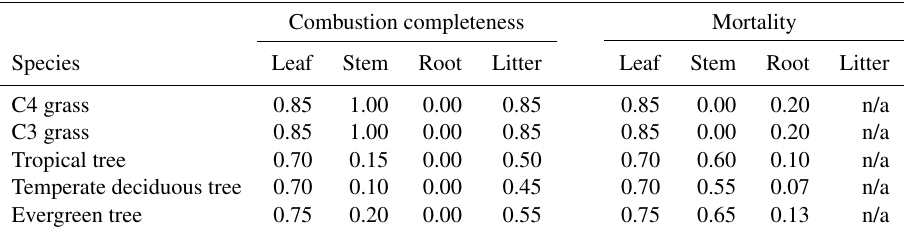
Table 1. Combustion completeness and mortality values for each “species” and tissue pool. Note that “stem” refers to both aboveground and belowground stem biomass, and that “root” refers only to fine roots. n/a – not